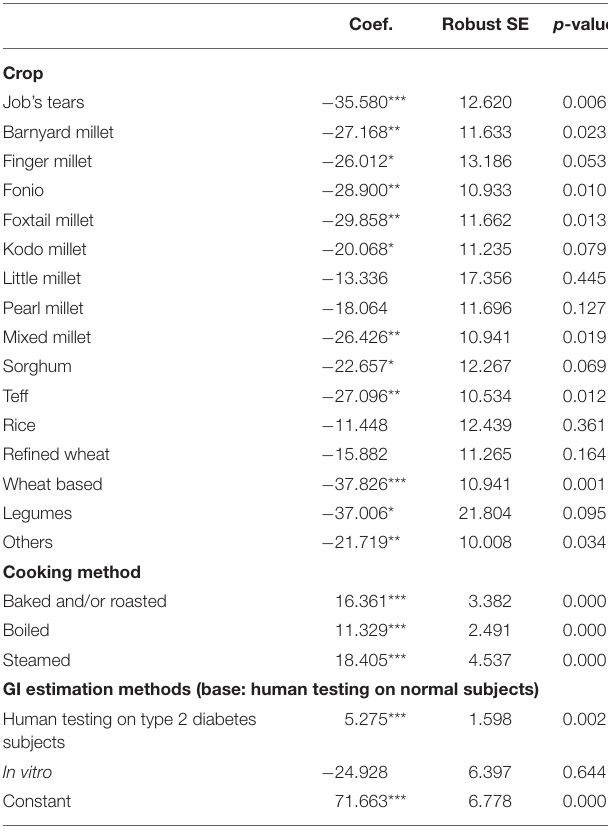
TABLE 4 | Frequency distribution of the independent variables in the regression analysis: crop, cooking method, and method used to determine GI ( n = 267). Crop Number of observation %